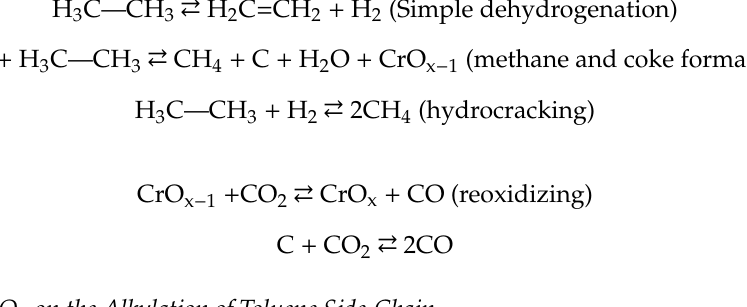
Table 8. Catalytic activity for the dehydrogenation of ethane (Reproduced from [73]; copyright (2008), Springer (Berlin, Germany)).